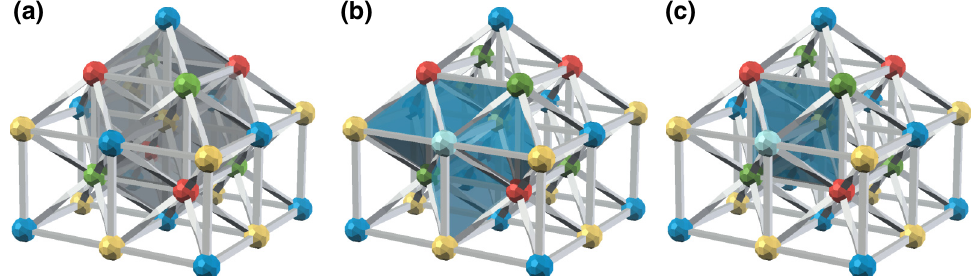
FIG. 10. (a) We show part of a 3-colex with a colorable 3-ball highlighted in gray. (b) We highlight (shaded blue tetrahedra) the support of the X -type stabilizer associated with the light blue vertex. (c) We show the intersection of the support of the stabilizer (b) with the colorable 3-ball (a). These qubits comprise the support of the ball-code logical X operator that is associated with the edge linking the light blue vertex and the central yellow